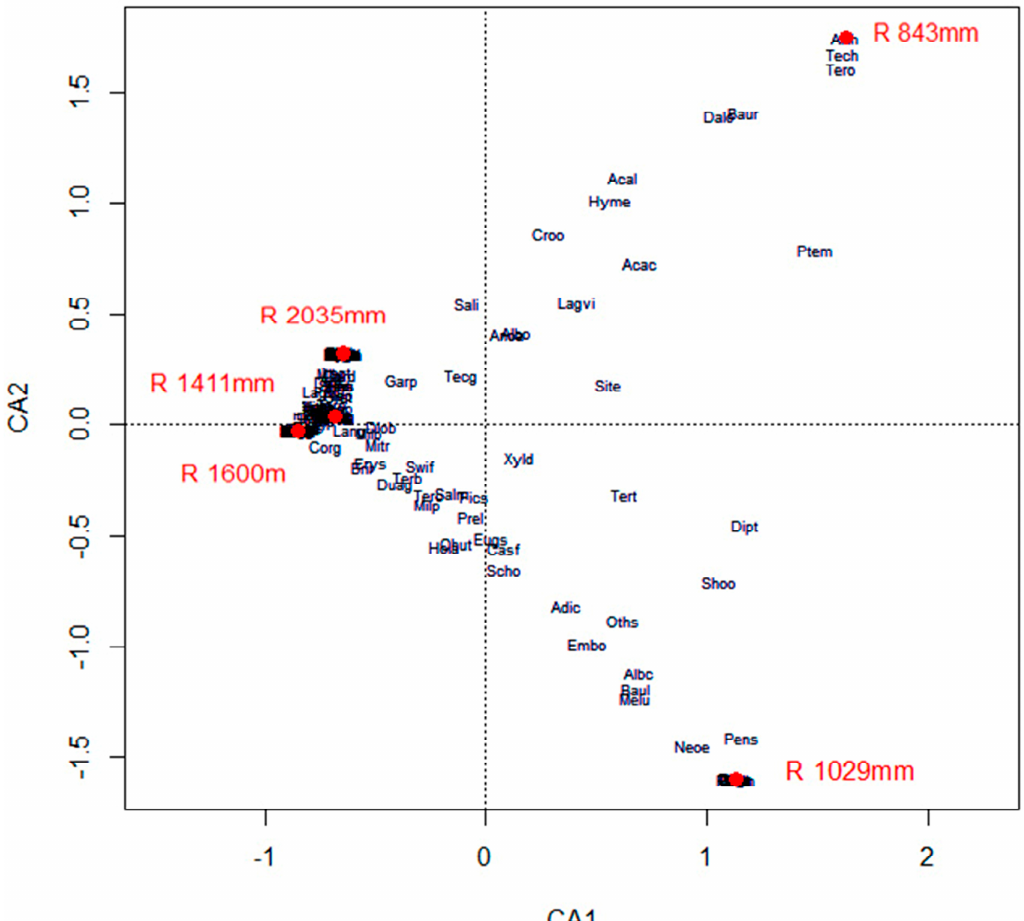
Figure 6. Correspondence analysis of species variables in relation to different annual rainfall regions. (The letters expressed in the figure are the abbreviations of species names, for example, Pens = Pentacme siamensis ). Species names and their abbreviations are shown in Table S7.